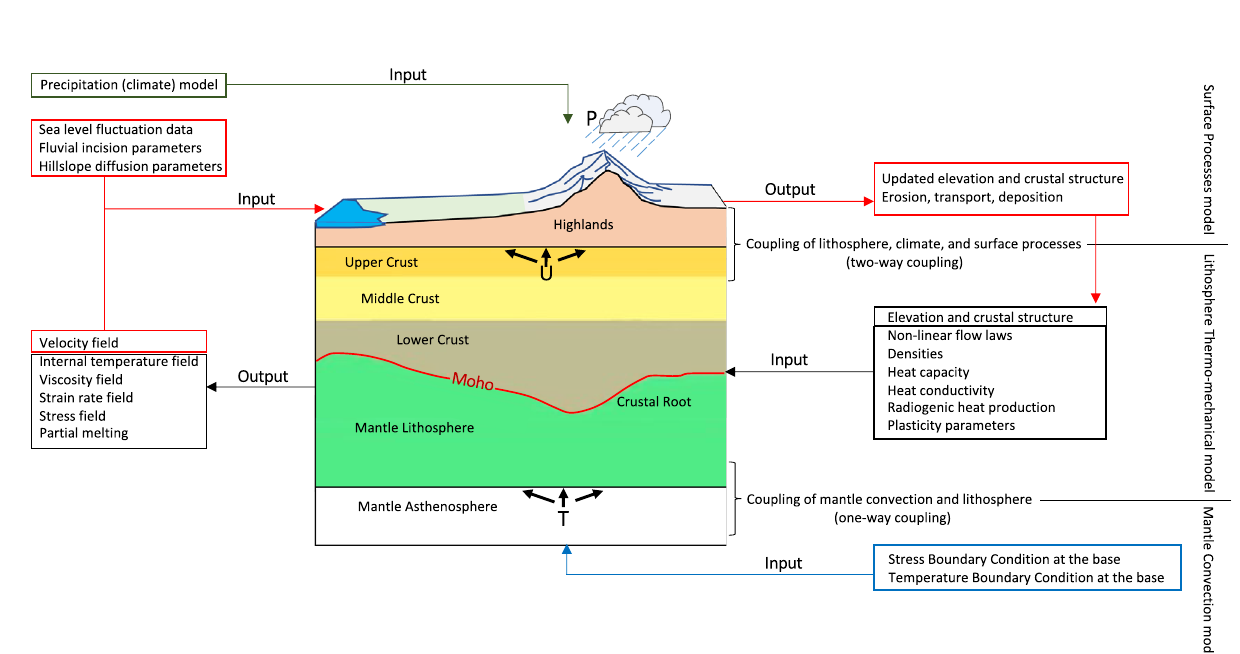
Fig. 1 Tectonic history and relation of mantle processes to surface geologic activity of southwestern North America. a Satellite image of southwestern North America showing the location of the Basin and Range Province (BRP), area surrounded by red dashed line, Colorado Plateau (CP), Rio Grande Rift (RGR), Great Plains (GP), and Sierra Nevada (SN) from Google Earth (2022). Red spots are the present-day locality of metamorphic core complexes, and red arrows represent vergence of Cordilleran metamorphic core complexes from Bahadori and Holt 10 . Light blue spots are the present-day locality of Miocene faults, and light blue arrows represent Miocene fault trends from Bahadori and Holt 10 . Color-coded dots represent distribution of magmatism at different times following the slab rollback from Bahadori and Holt 10 . b A representation of the Laramide orogeny showing the southwestern margin of North America with subducted Farallon Slab in contact with North American Plate at around 60 Ma modi fi ed from Humphreys 26 . c A representation of the Farallon Slab tearing, partial melting, ignimbrite fl are-up, magmatism, and crustal extension in southwestern North America at 35 Ma modi fi ed from Humphreys 26 . The map images were created by authors using: www.soest.hawaii.edu/gmt/ and www.paraview.org/.